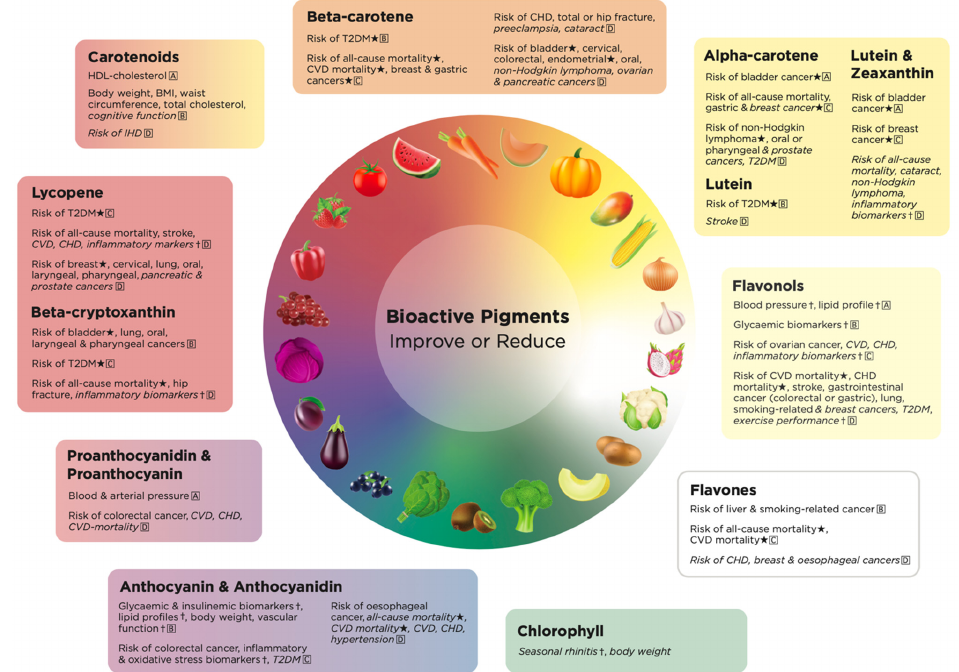
Figure 2. The health promoting effects of bioactive pigments by color in fruits and vegetables. GRADE working groups of evidence: A = high quality, further research is unlikely to change our confidence in the estimated effect; B = medium quality, further research is likely to have an important impact on our confidence in the estimate of effect and may change the estimate; C = low quality, further research is very likely to have an important impact on our confidence in the estimate of effect and is likely to change the estimate; and D = very low quality, we are very uncertain about the estimate. ⋆ = dose–response established. † = cause and effect established. Health effects in italics are those with small effect sizes. BMI, body mass index. CVD, cardiovascular disease. CHD, coronary heart disease. IHD, ischemic heart disease. T2DM, type 2 diabetes.